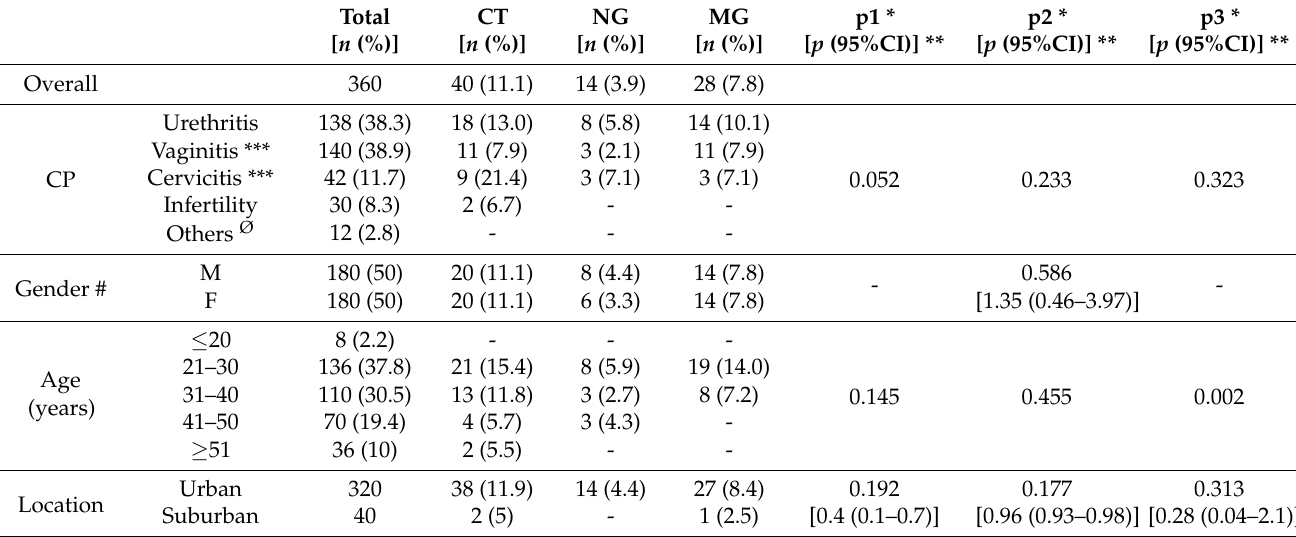
Table 1. Distribution of sexually transmitted bacteria according to the clinical presentation (CP), gender, age, and settlement of